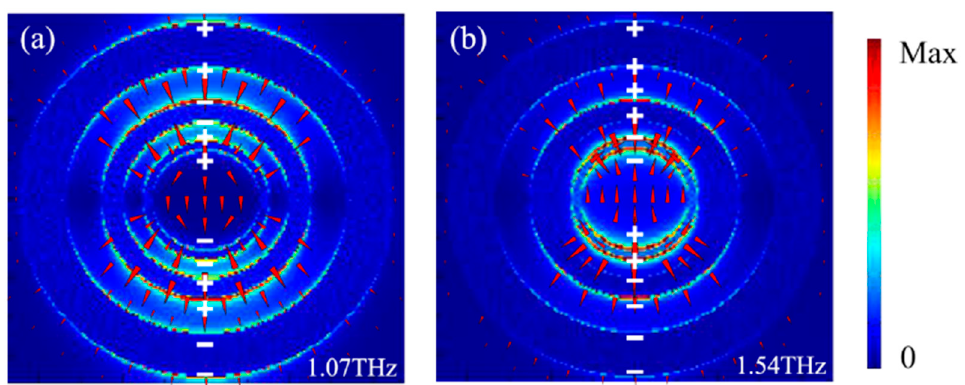
Figure 5. Simulated electric field patterns (arrow for the direction and color for the contrast of the field strength) at the top graphene layers of the MPAs in Figure 3. Red line at the absorption peak. ( a ) is the peak at the 1.07 THz and ( b ) is the peak at the 1.54 THz.